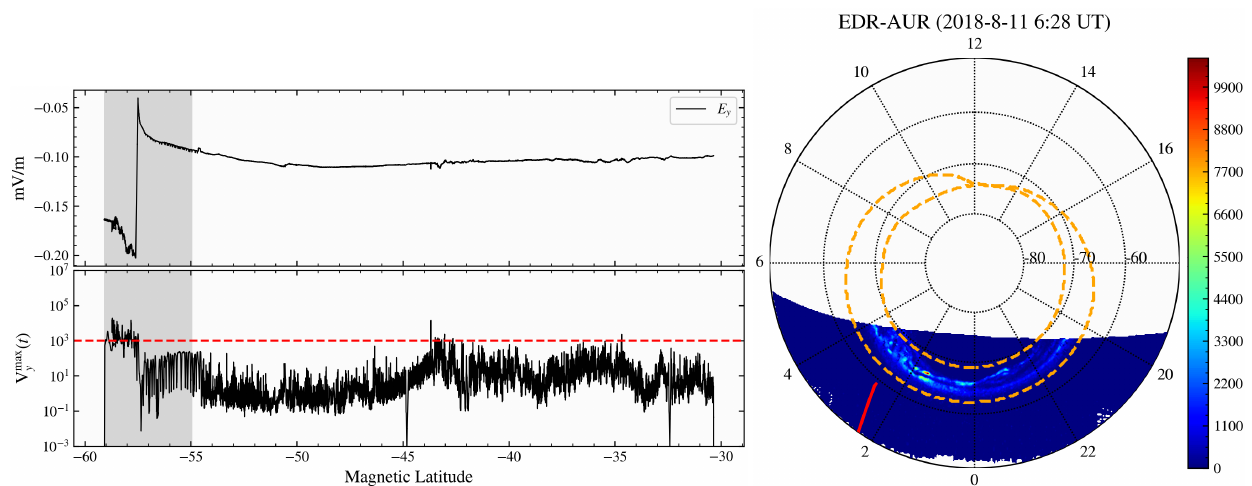
Figure 8. Same as Figure 7, except for orbit 2888. Negative detection, nightside southern hemisphere.